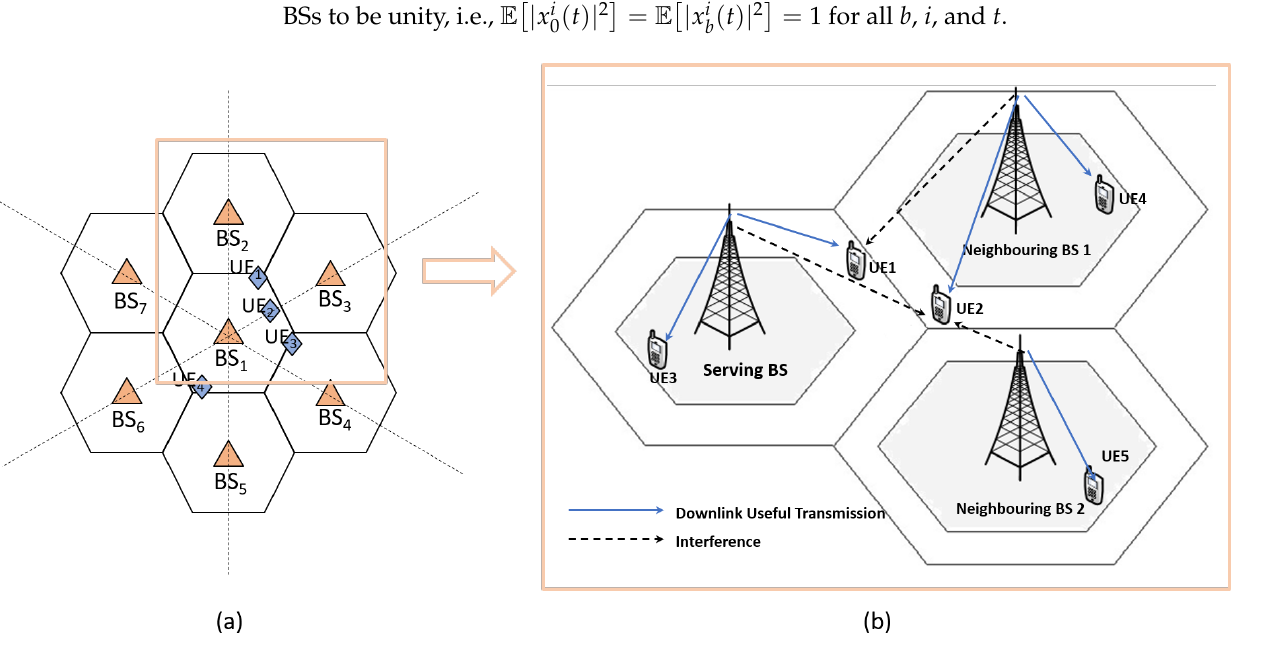
Figure 1. Subfigure ( a ) shows the inter-cell interference between UE and base stations in the multi-cell scenario. The hexagon is the transmission range of the base station signal. Subfigure ( b ) shows the inter-cell interference scenario abstracted from A, where UE1 has one interference cell and UE2 has two interference